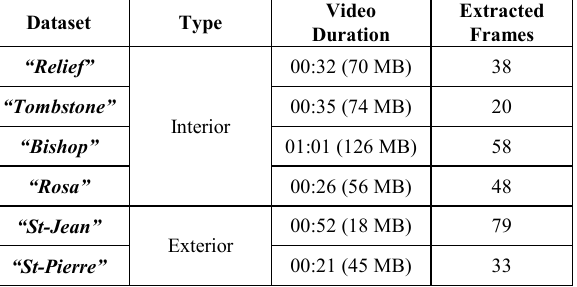
Table 1. Characteristics of the input video for the objects described in Figure 2. All videos were shot using a Moto G7 with an FHD 1080p